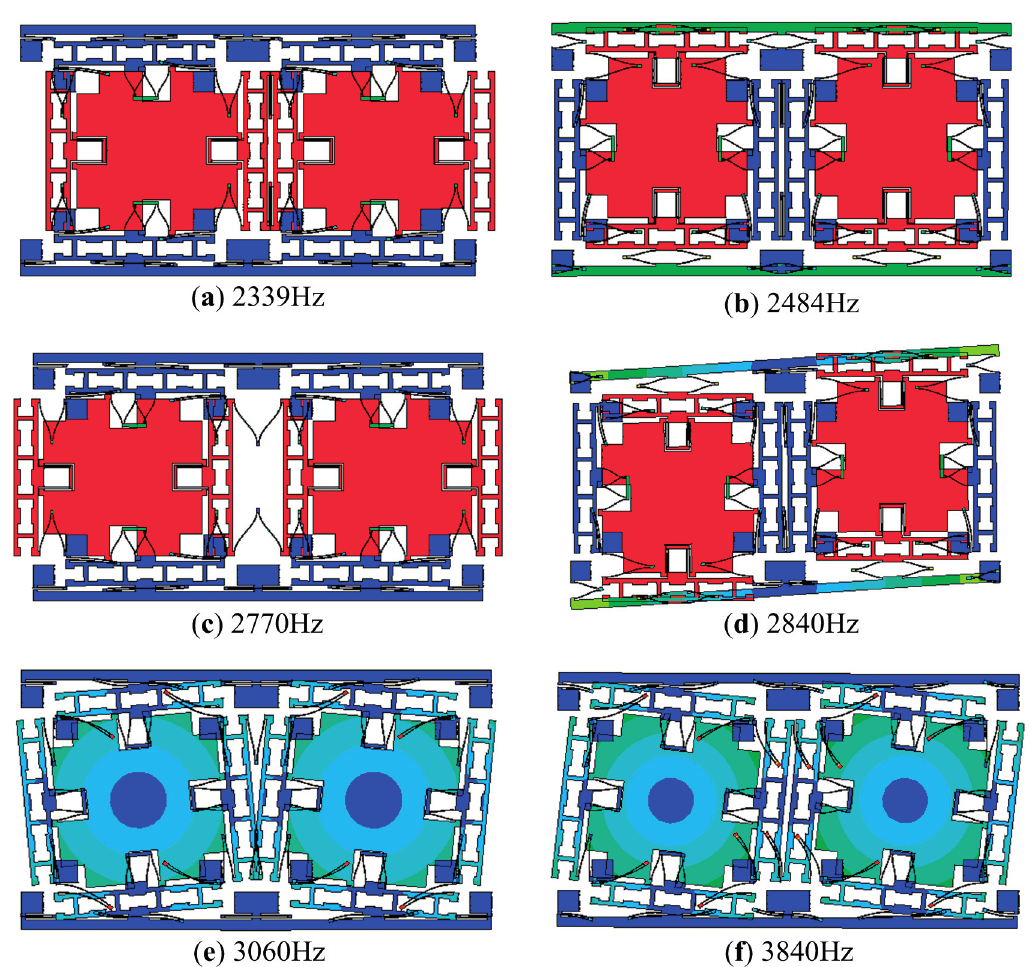
Figure 2. The first six modes of the micro-gyroscope: ( a ) in-phase mode in drive direction; ( b ) in-phase mode in sense direction; ( c ) anti-phase mode in drive direction; ( d ) anti-phase mode in sense direction; ( e ) anti-phase torsional mode; ( f ) in-phase torsional